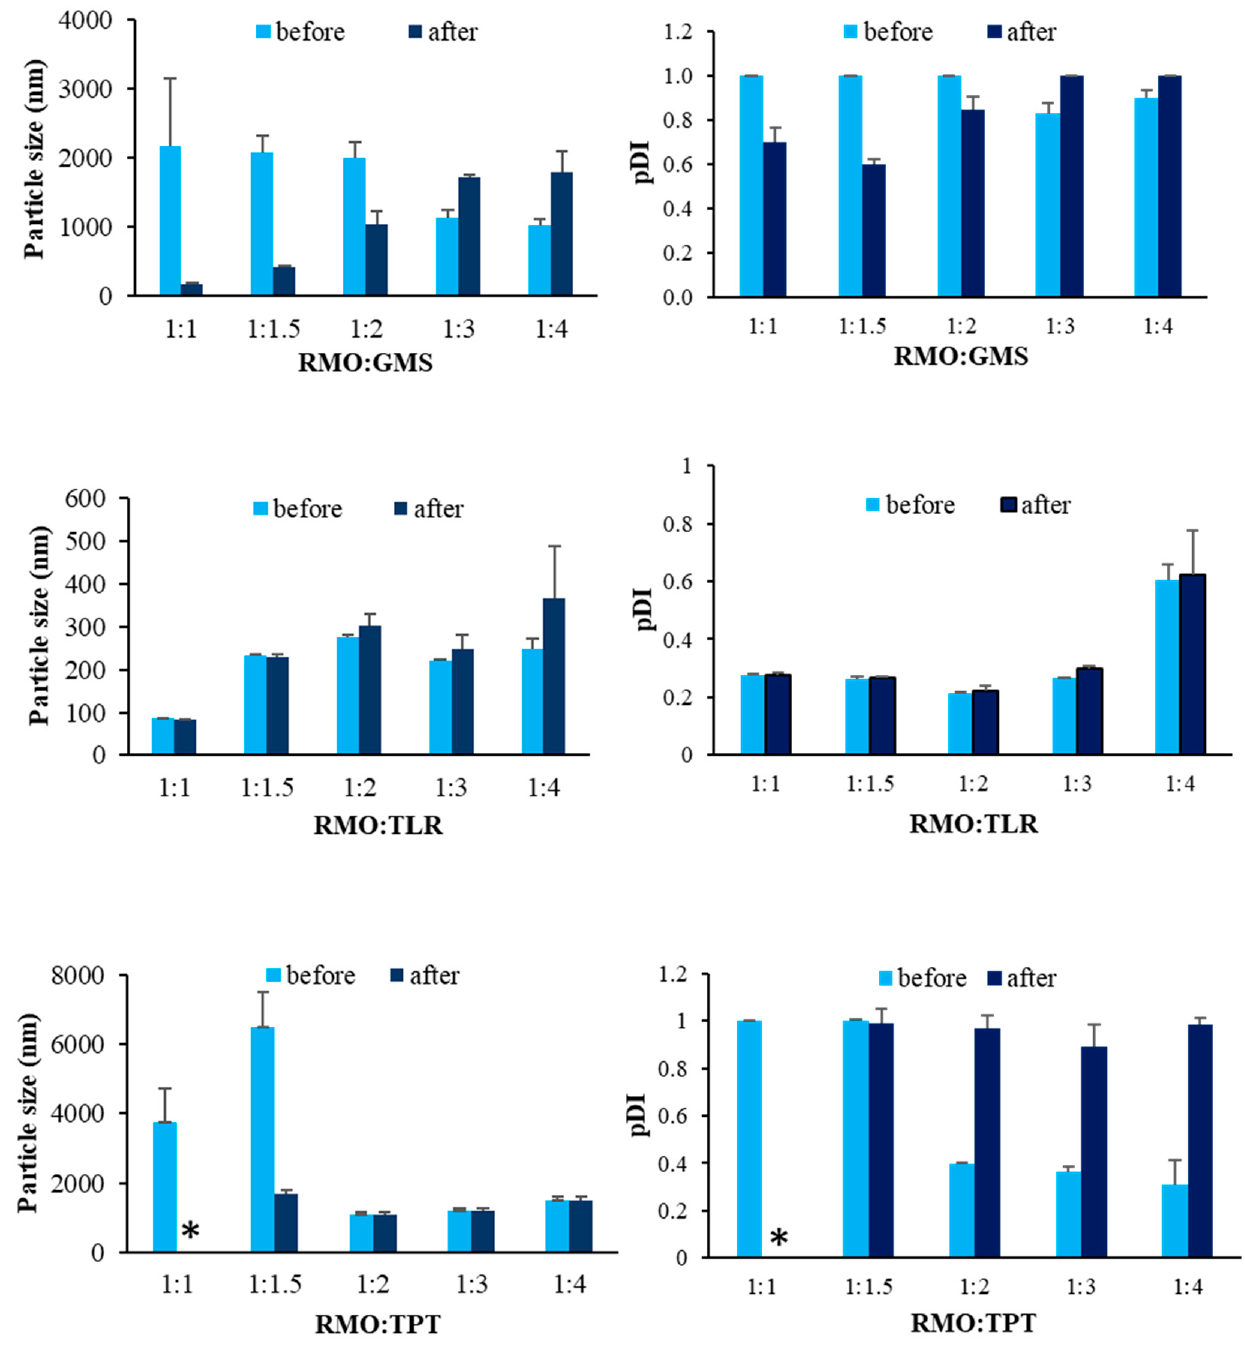
Figure 2. Particle size and size distribution (pDI) of SLNs prepared from different types and ratios of solid lipid before and after temperature cycling test. * represents phase separation.